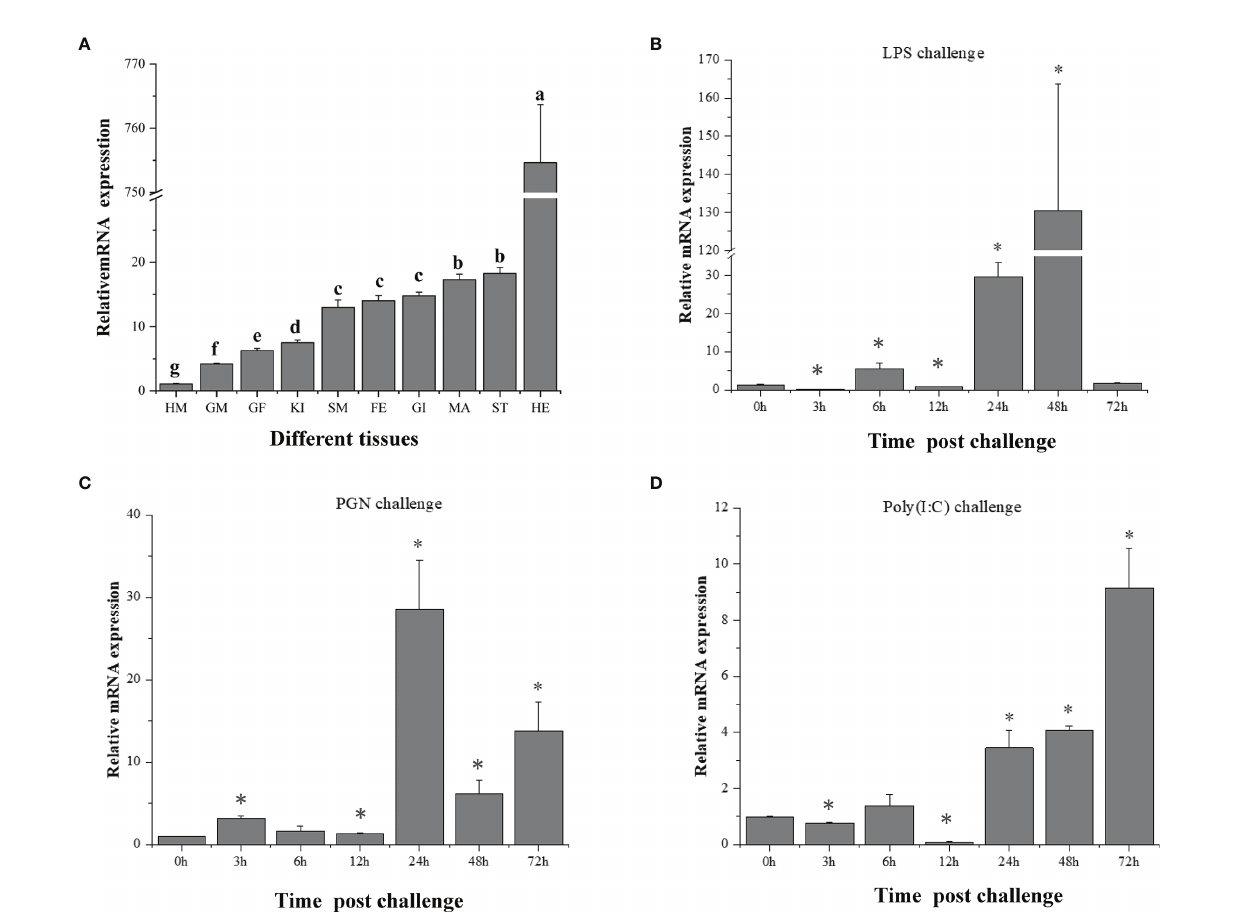
FIGURE 4 | Expression of CfIKK1 mRNA in different tissues (A) and after pathogen-associated molecular pattern challenges (B – D) , as determined using qRT-PCR. The EF-1 a gene was used as an internal control, and hemocytes were used as a reference sample. The tissue-expression data were statistically analyzed with one- way ANOVA followed by a multiple comparison. Different letters indicate that the differences are signi fi cant ( p < 0.05). For the challenge experiment, the different stimulants were LPS, PGN, and poly(I:C). The CfIKK1 mRNA expression level in gill tissues was determined at 0, 3, 6, 12, 24, 48, and 72 h after challenge. EF-1 a gene expression was used as an internal control, and time 0 h was used as a reference sample. Vertical bars represent the mean ± SD (N = 3). * p < 0.05, according to the unpaired two-tailed t -test. HM, hemocytes; GM, male gonad; GF, female gonad; KI, kidney; SM, smooth muscle; FE, feet; GI, gill; MA, mantle; ST, striated muscle; HE, hepatopancreas; LPS, lipopolysaccharide; PGN, peptidoglycan; poly (I:C), polyinosinic – polycytidylic